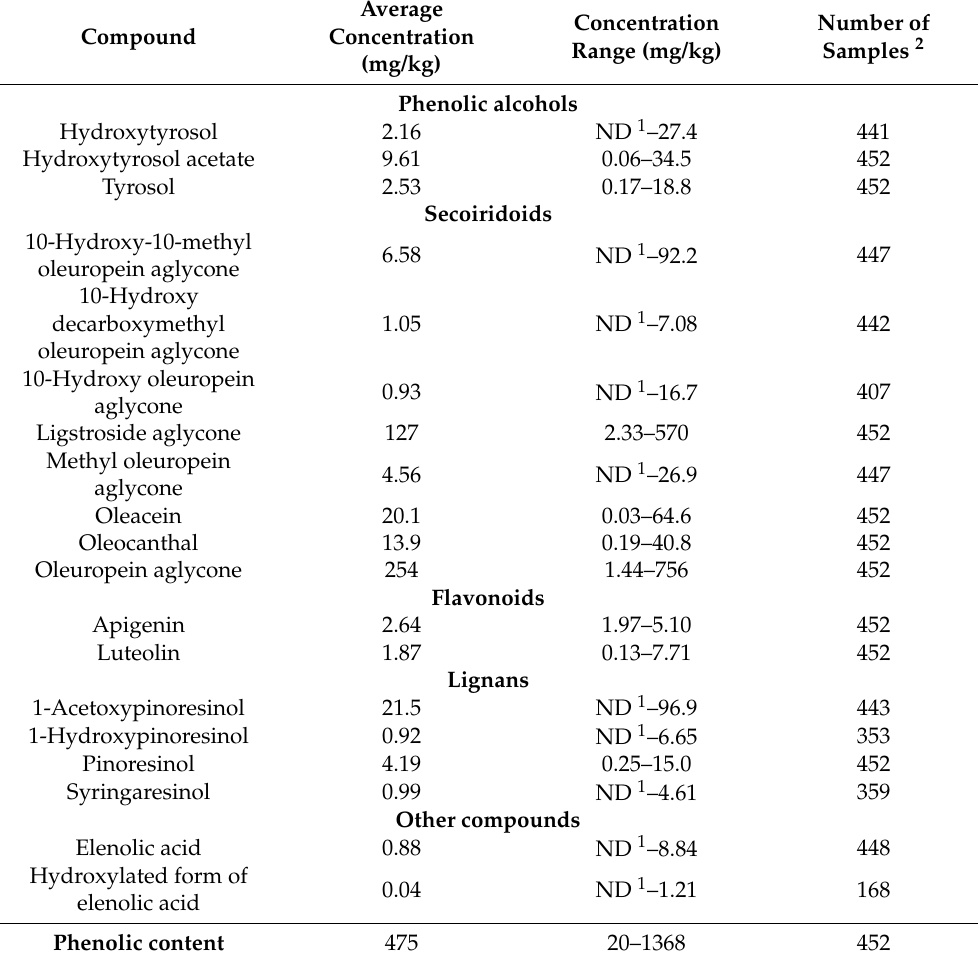
Table 3. Quantification and semiquantification results in